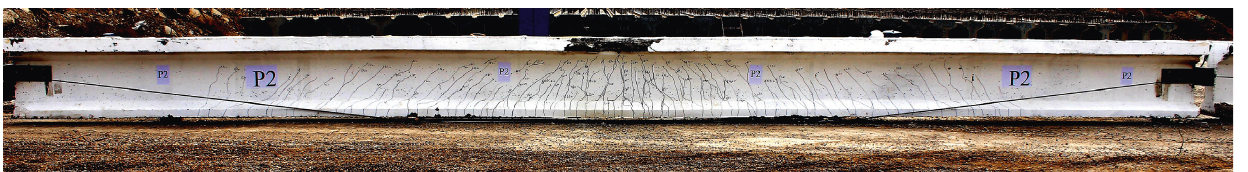
Figure 15: Crack pattern of girder P2 after